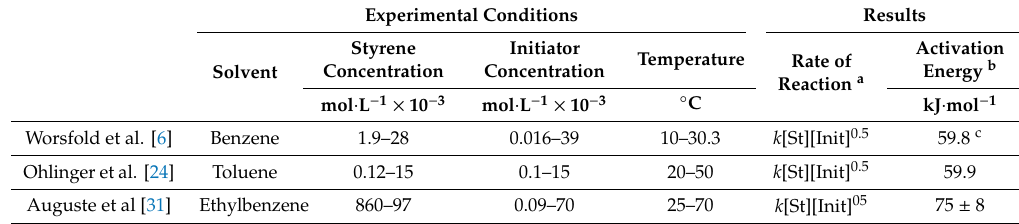
Table 4. Experimental conditions and results of the experiments performed to determine the apparent activation energies for the anionic polymerization of styrene (this was also discussed in our previous paper.). Experimental Conditions